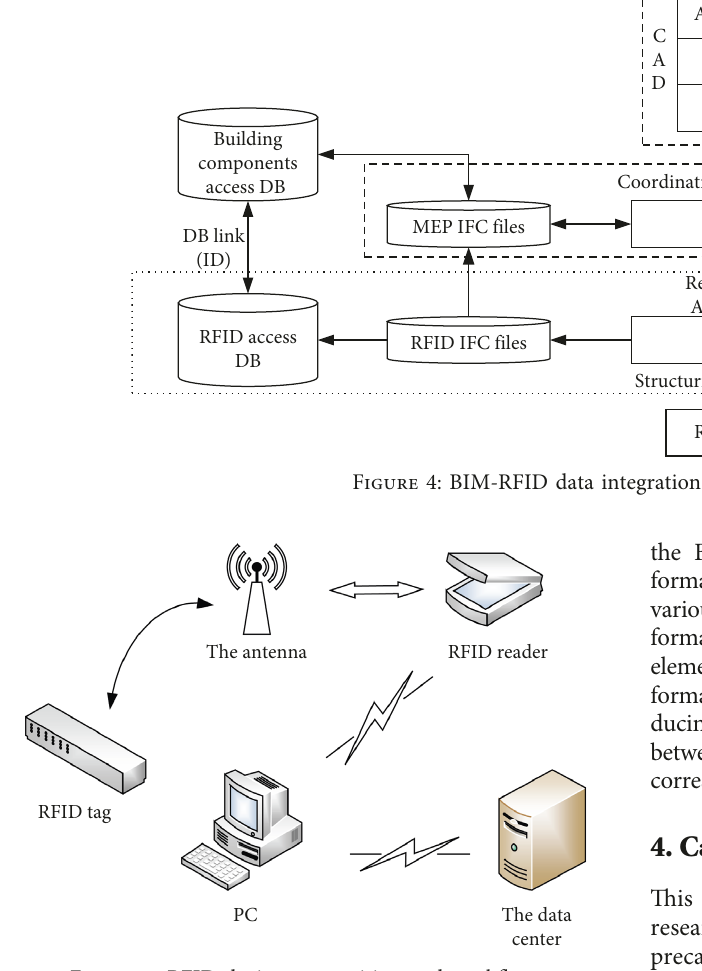
Figure 5: RFID device composition and